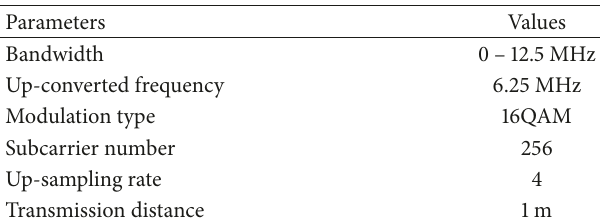
Table 1: System parameters.